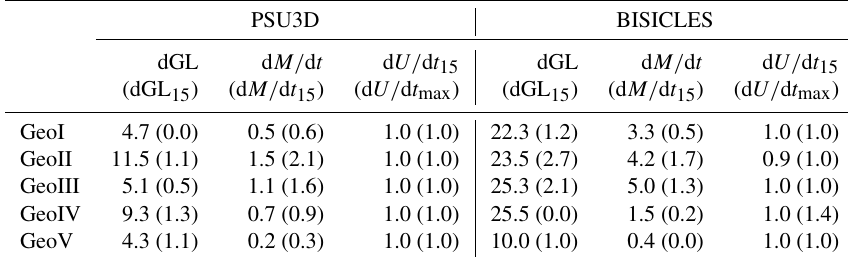
Table A4. Same as for Table A1 but for George VI embayment and Experiment